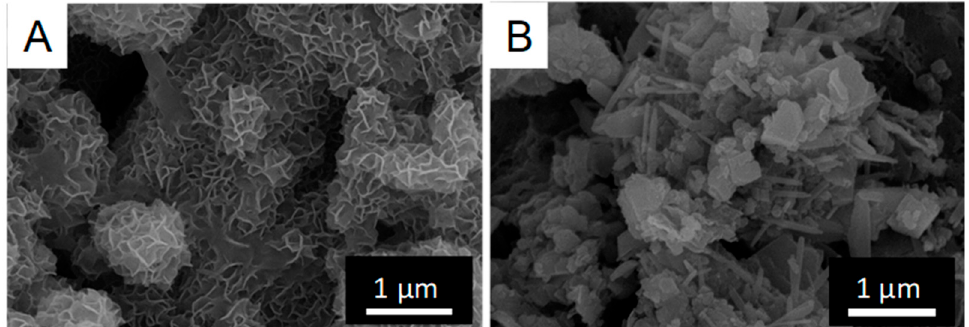
Figure 6. SEM observations of CSMS. ( A ) Granules with petal-like patterns were found on the surface of the CSMS incubated with TO1 culture. ( B ) Granules without petal-like patterns were found on the surface of the CSMS incubated with the sterilized medium.